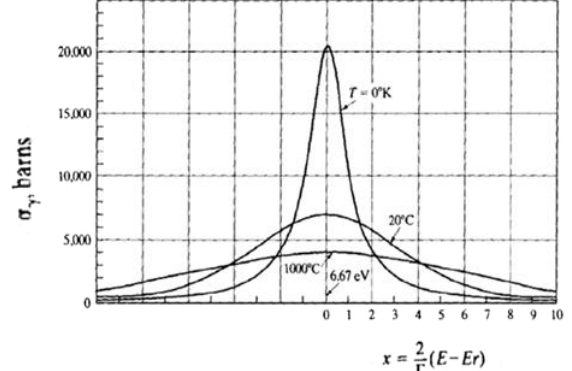
Figure 3: Shape of the resonance with mean energy 6.67eV in uranium depending on energy at three different temperatures. [8] 238 𝑈𝑈